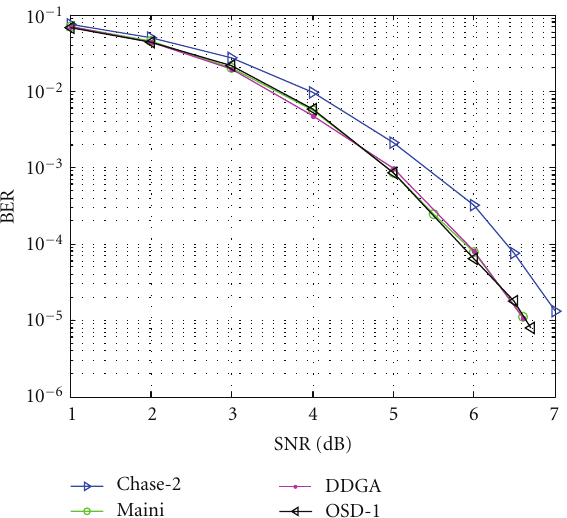
Figure 14: Performances of Chase-2, OSD-1, Maini, and DDGA algorithms for BCH (63,45,7) code.